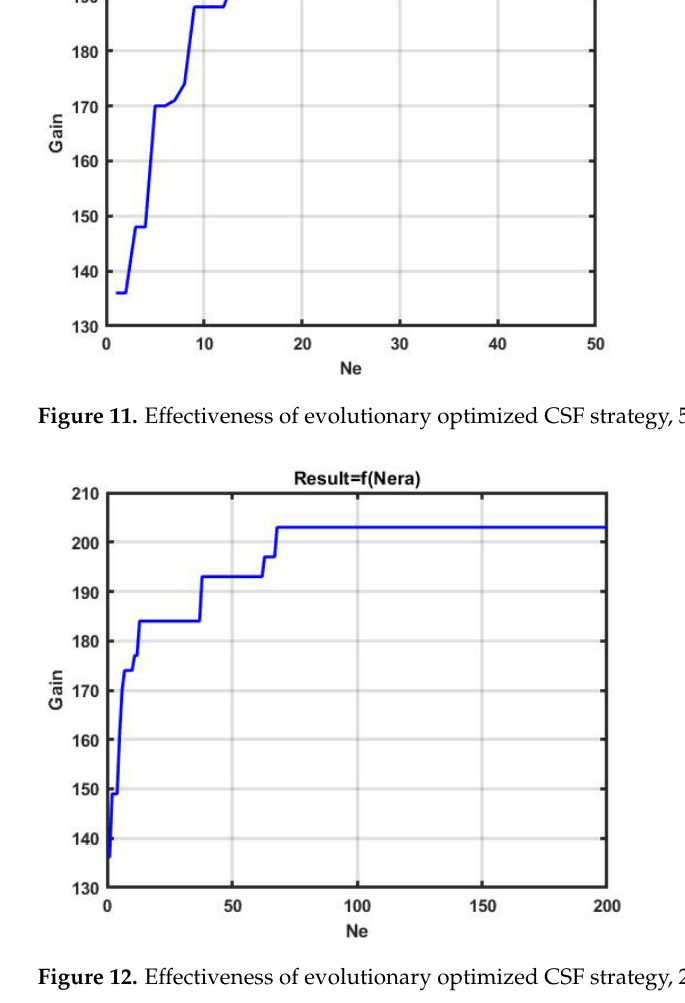
Figure 12. Effectiveness of evolutionary optimized CSF strategy, 200 epochs.